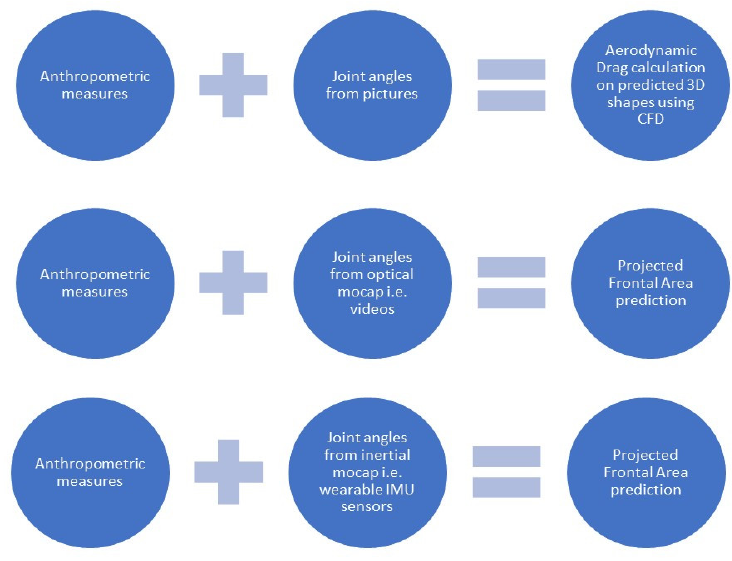
Figure 4. Schematic diagram of the methods evaluated in this study.